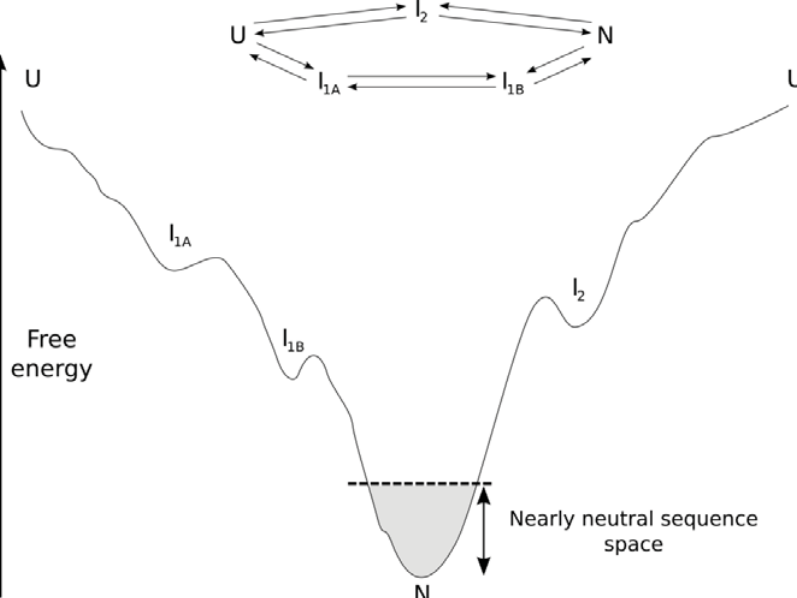
Figure 1. A possible conformational energy landscape for a typical structured protein. The protein has two alternative folding pathways (top), proceeding from the unfolded state (U) to the native state (N) through one (I2) or two (I1A, I1B) intermediate conformations. The funnel-shaped landscape guarantees rapid folding to the native state, passing various metastable states with different rates of interconversion on the way. The shaded area near the native state indicates the magnitude of change in folding energy that is selectively neutral (dependent upon to population size Ne and selective pressure